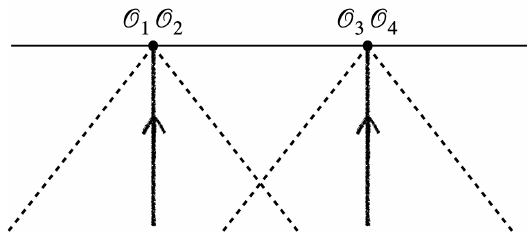
Figure 9 . The evolution of operators in the bulk is indicated by the lines with arrows. Operators O 1 and O 2 are close by and evolve together, so do operators O 3 and O 4 . Pairwise they evolve independently once their static patches stop to overlap and they get separated by cosmological horizons, indicated by the dashed